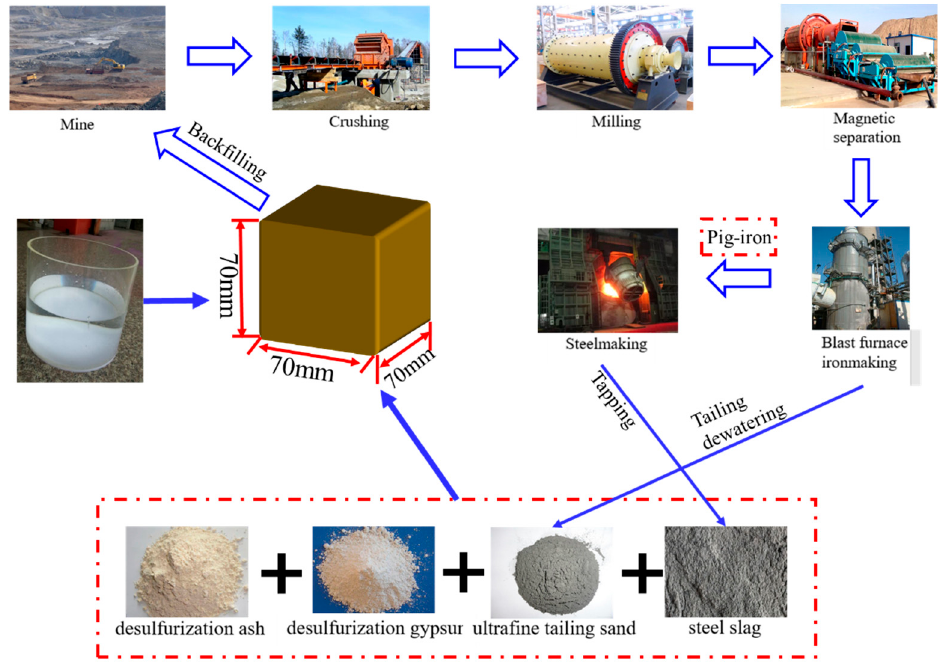
Figure 1. Experimental flow chart.